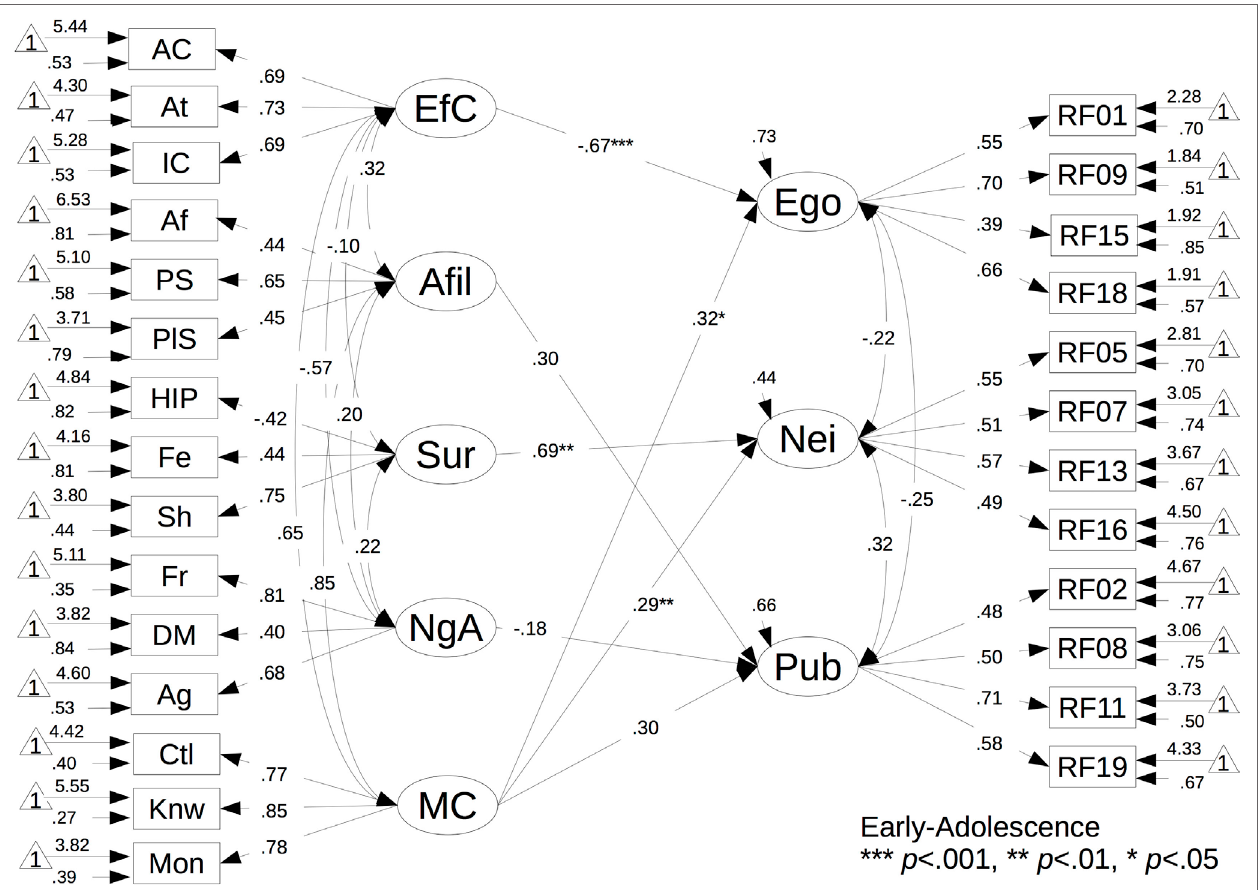
FigUre 2 | Path diagrams for early-adolescence group for temperament, metacognition, and frames of reference in behaviors in public situations by multiple group structural equation modeling. EfC, effortful control; Afil, affiliativeness; Sur, surgency; NgA, negative affect; AC, activation control; At, attention; IC, inhibitory control; Af, affiliation; PS, perceptual sensitivity; PlS, pleasure sensitivity; HIP, high-intensity pleasure; Fe, fear; Sh, shyness; Fr, frustration; DM, depressive mood; Ag, aggression; MC, metacognitive awareness; Mon, monitoring; Ctl, control; Knw, metacognitive knowledge; Ego, egocentrism; Nei, neighborhood evaluation; Pub, public values. * p < 0.05, ** p < 0.01, *** p <